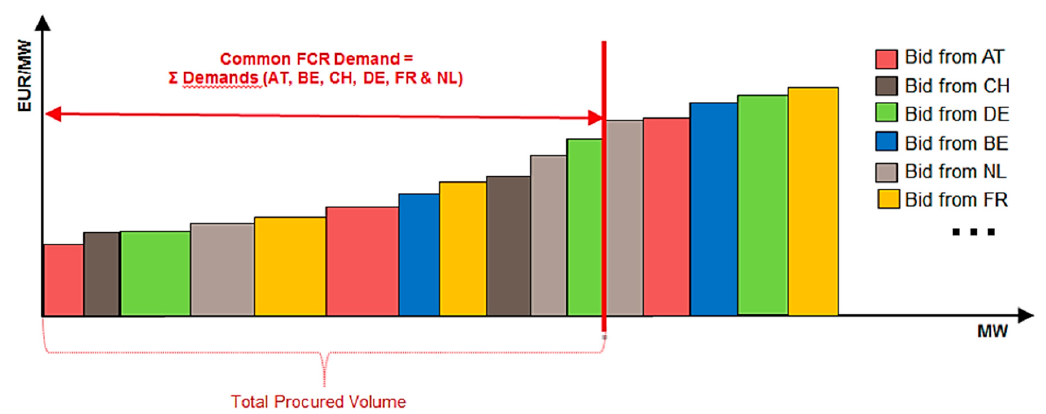
Figure 5. FCR cooperation market merit order pricing methodology, [38]. FCR: Frequency Containment Reserve AT: Austria, CH: Switzerland, DE: Deutschland, BE: Belgium, NL: Netherlands, FR: France.